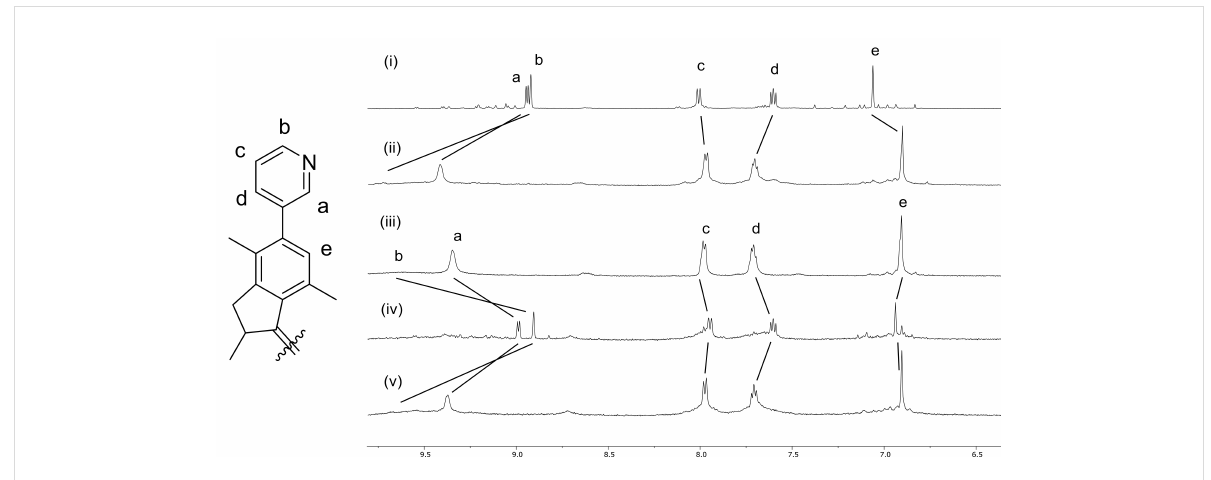
Figure 5: Aromatic region of stacked 1 H NMR spectra (CD 3 CN/CD 2 Cl 2 1:1) of i) Pd 2 (stable Z - 1 ) 4 ; ii) Pd 2 (stable E - 1 ) 4 generated by irradiation of Pd 2 (stable Z - 1 ) 4 at 312 nm; iii) Pd 2 (stable E - 1 ) 4 prepared directly from ligand stable E - 1 ; iv) Pd 2 (unstable Z - 1 ) 4 generated by irradiation of Pd 2 (stable E - 1 ) 4 at 312 nm and v) Pd 2 (stable E - 1 ) 4 generated by irradiation of Pd 2 (unstable Z - 1 ) 4 at 365